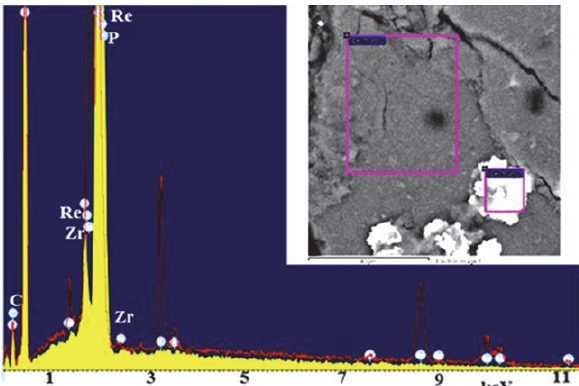
Fig. 5 EDX spectrum of І/ZrP 1:5